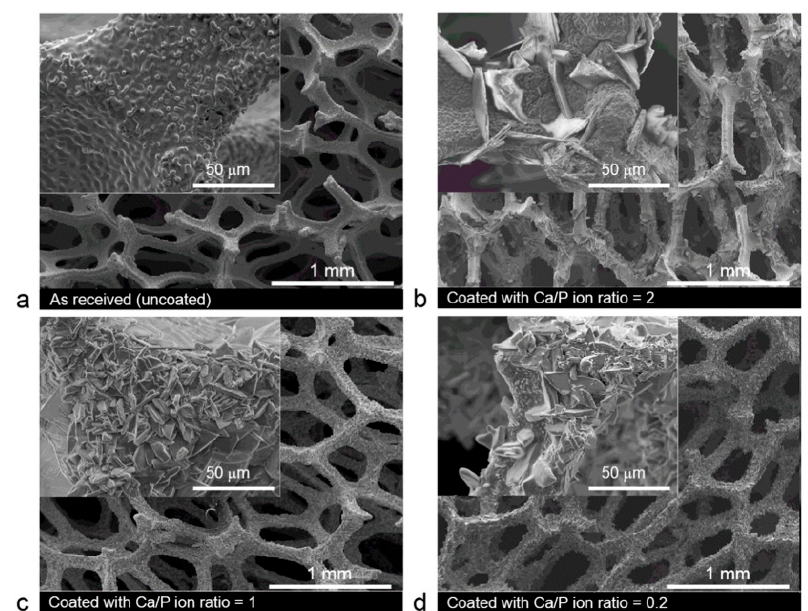
Figure 17. An interfacial bonding of coated and uncoated samples, formed between the substrate and mineralization layer compared to the uncoated samples: ( a ) iron samples as received, and ( b – d ) coated in different phosphating baths with Ca/P ion ratio of ( b ) 2, ( c ) 1, and ( d ) 0.2. Reprinted from Reference [35] with permission from Elsevier.